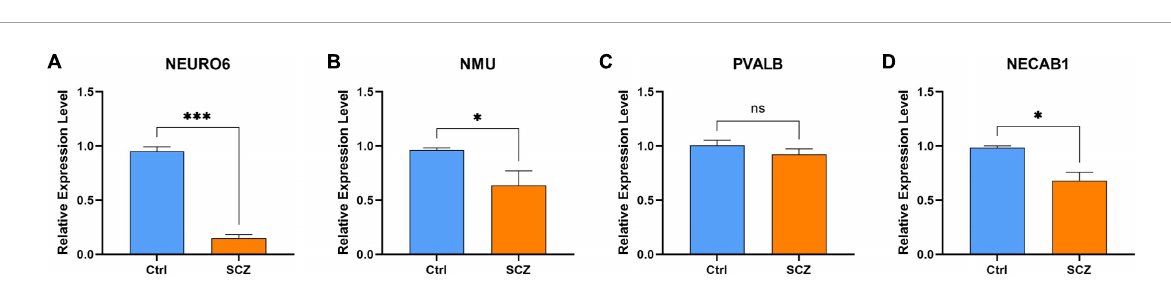
FIGURE12 qPCR validation. Comparison of gene expression between SCZ rat model and control in (A) NEURO6, (B) NMU, (C) PVALB, and (D) NECAB1. ∗ P < 0.05, ∗∗∗ P < 0.001 vs.